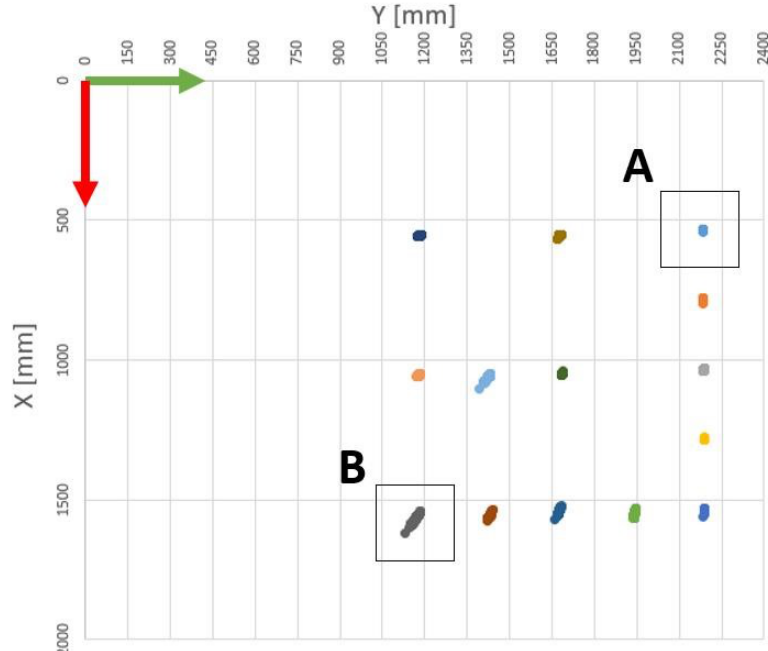
Figure 9. Detection accuracy of a single camera in a real experiment. Every color represents a different set of measured positions. It is the red camera in Figure 5, specifically.